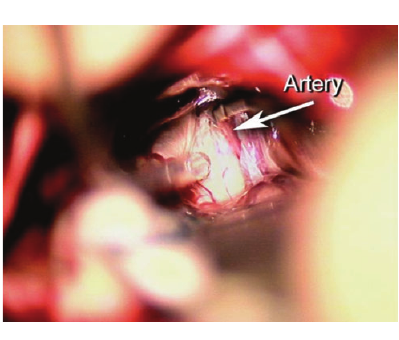
Figure 2. View through microscope of left cerebral peduncle in patient with Parkinson’s Disease. Arrow points to PCA partly buried in the midbrain.